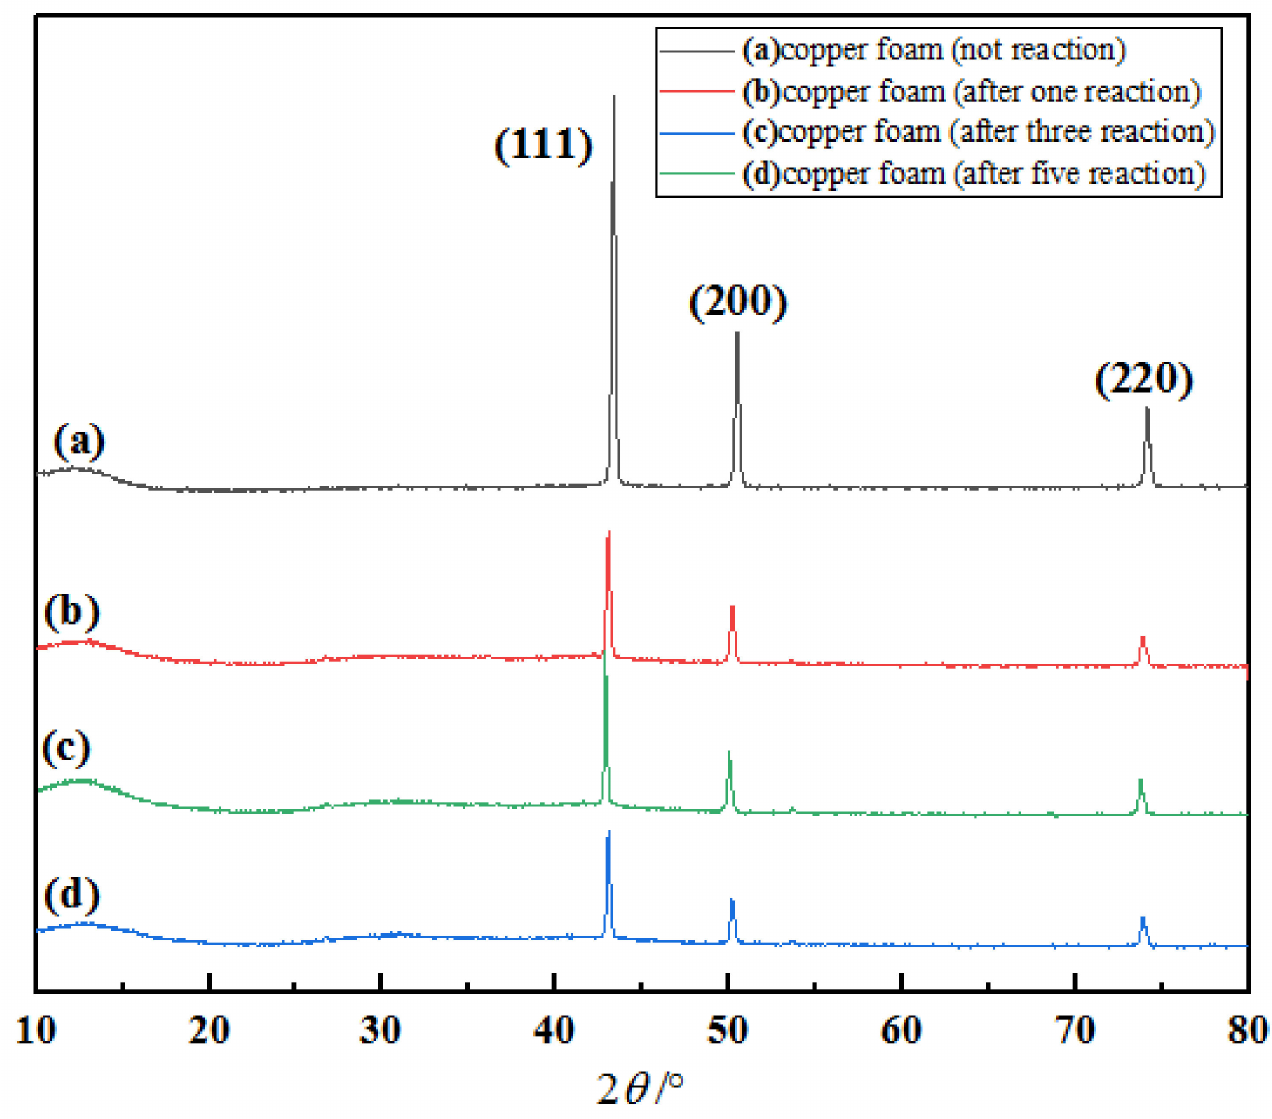
Figure 4. The XRD analysis of ( a ) copper foam (no reaction), ( b ) copper foam (after one reaction), ( c ) copper foam (after three reaction), and ( d ) copper foam (after five